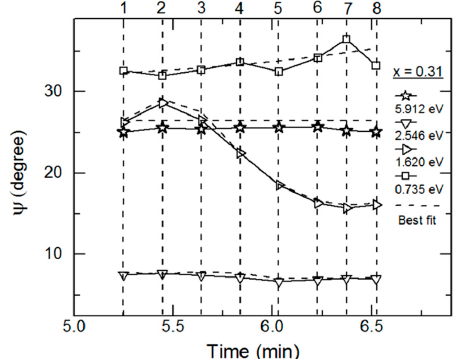
Figure 4. RTSE data (points) collected at the photon energy values of 0.735, 1.620, 2.546 and 5.912 eV for the IGS thin film deposition with x = 0.31. Data analysis was performed to extract the time evolution of the film structure and the ( ε 1 , ε 2 ) spectra of IGS over the analysis range from 0.74 to 6.0 eV. The dashed lines represent the best fit to the data using the structural model of Figure 3 and a Kramers-Kronig consistent b-spline model for the ( ε 1 , ε 2 ) spectra with a node spacing of 0.2 eV. Structural parameters at the starting, center and ending points are given in Table 1. In such multi-time analyses, the ( ε 1 , ε 2 ) spectra are assumed to be time independent from the start of deposition throughout the time-period of multi-time analysis, yielding a structural model for film growth having a single uniform bulk layer.